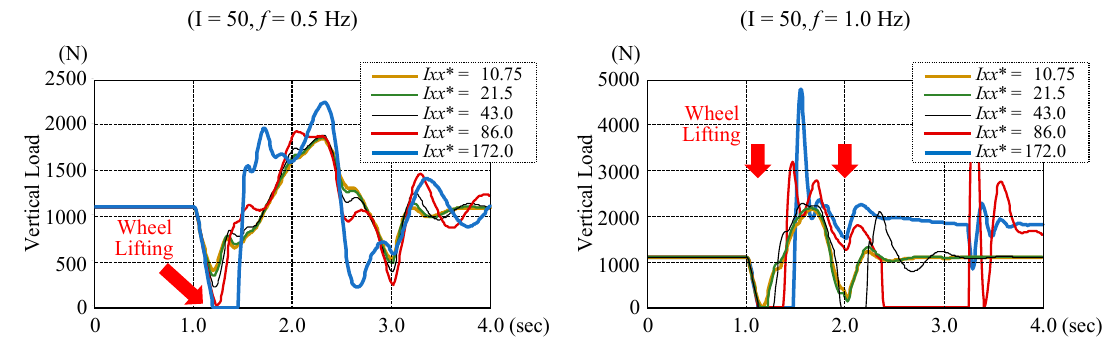
Figure 13. Influence of roll moment of inertia on vertical load of front left wheel (I = 50).